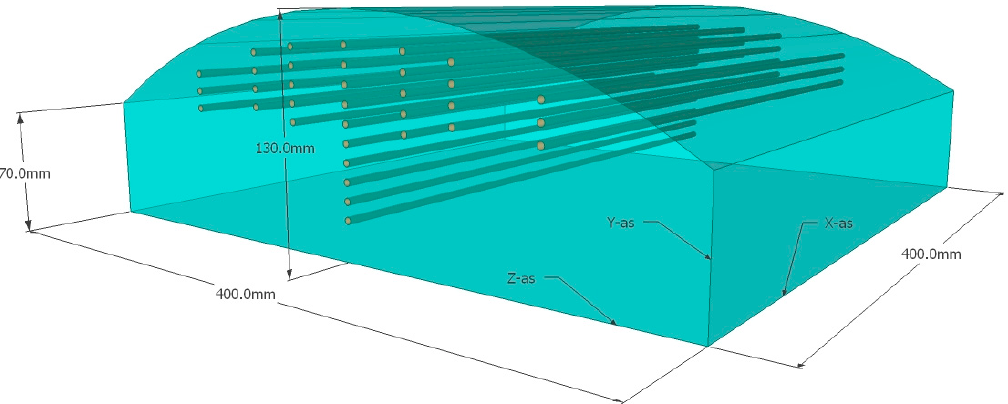
Figure 4. The slightly curved muscle-equivalent phantom used in the experiment to evaluate the power distribution pattern with the infrared (IR) camera. Catheters are positioned inside the phantom for invasive thermometry. The 10 mm thick fat-equivalent layer that can be positioned on top is not depicted. IR images are taken of the surface of the muscle-equivalent phantom and the 10 mm fat-equivalent layer.